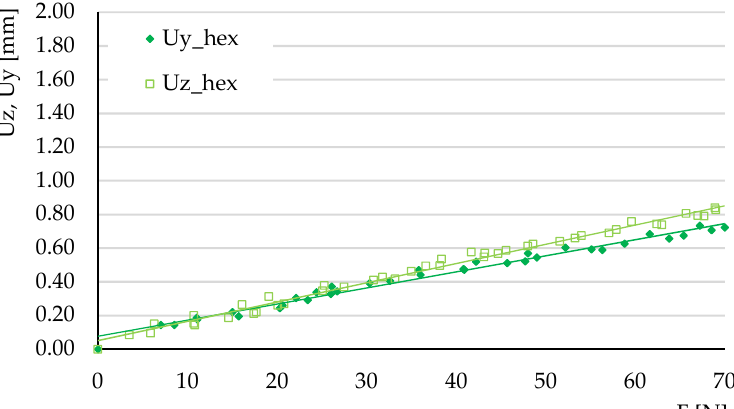
Figure 14. The variations of deflections Uy = f ( Fy ) and Uz = f ( Fz ) for the hexagonal structure, in experimental three-point bending.